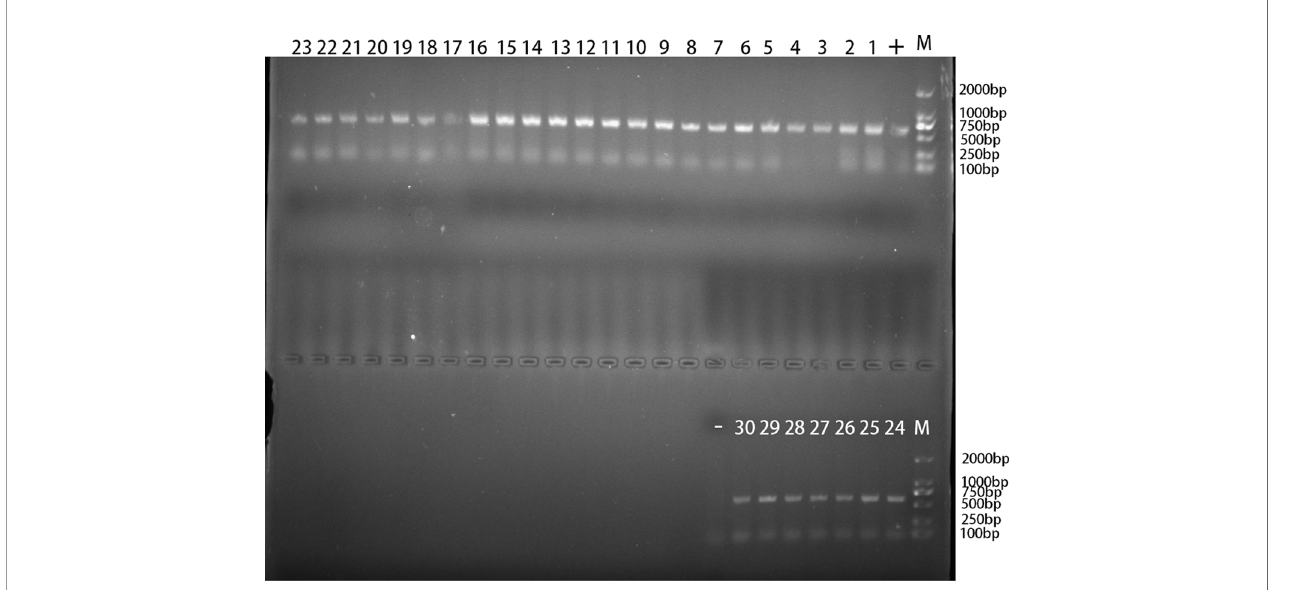
FIGURE 2 | The PCR ampli fi cation result of Blastocystis rRNA gene. “ 1 – 30 ” : 30 positive samples of Blastocystis in TA25, TA26, TA72, TA100, TA103, TA105, TA107, TA108, TA111, TA118, TA124, TA128, TA130, TA131, TA147, TA148, TA156, TA157, TA169, TA175, TA214, TA216, TA228, TA230, TA232, TA235, TA238, TA252, TA291, and TA307; “ - ” : negative control; “ + ” : positive control; “ M ” : DL2000 Marker.